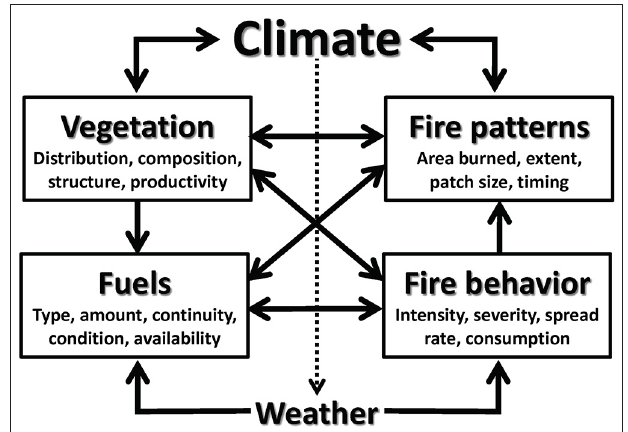
FIGURE 1 | In fire-prone ecosystems, landscape vegetation patterns are determined by reciprocal interactions with fire and interactions within and among species and the surrounding environment. Climate and weather, vegetation, and fire interact in a complex of synergistic and antagonistic effects that amplify the impacts of disturbance on ecosystems. Climate influences landscape vegetation patterns and fuel characteristics at long time scales, whereas weather is short-term driver of fuel flammability and fire behavior. Globally, positive feedbacks may exist between climate warming, fire activity, carbon loss, and future climate change. This combination of scale dependent and spatially overlapping processes produces complex spatial patterns that are a central challenge in natural resource planning. Accounting for this complexity may require new approaches such as process-based simulation models that integrate multiple feedbacks, simultaneous interactions, and anthropogenic